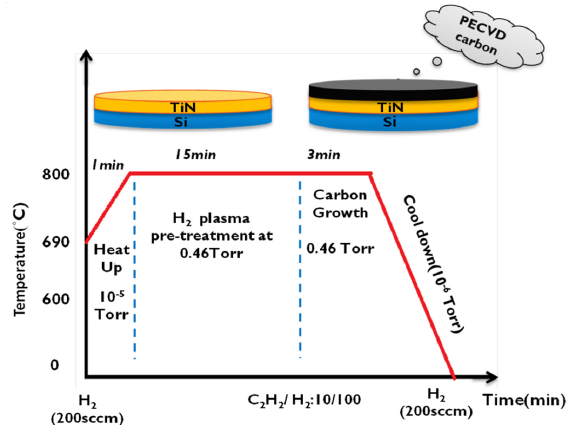
Figure 2. Representation of the process of PECVD carbon deposition and its profile. In this graph, the experimental parameters (Gas flow, temperature setting) are diagrammatically shown. experimental parameters (Gas flow, temperature setting) are diagrammatically